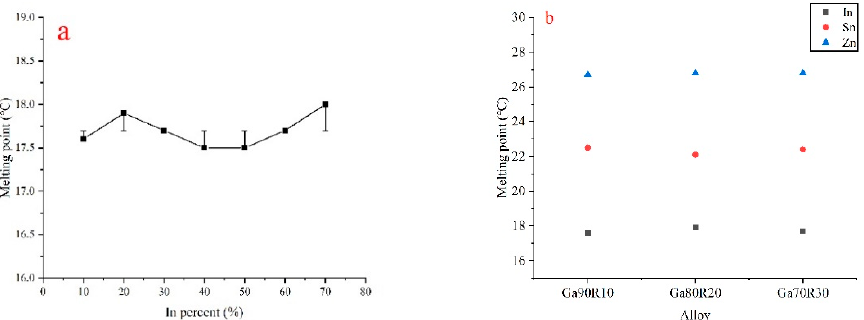
Figure 4. ( a ) Melting point of GaIn alloys (with error bar); ( b ) Melting point of binary gallium alloys.